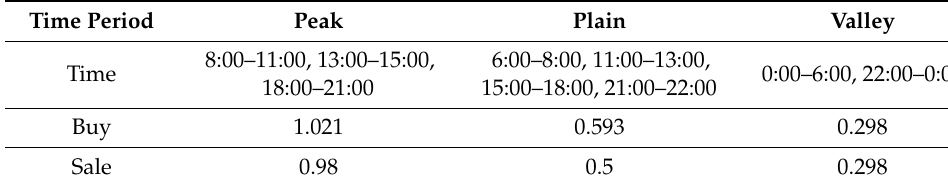
Table 1. Electricity purchase and sale price in different periods.